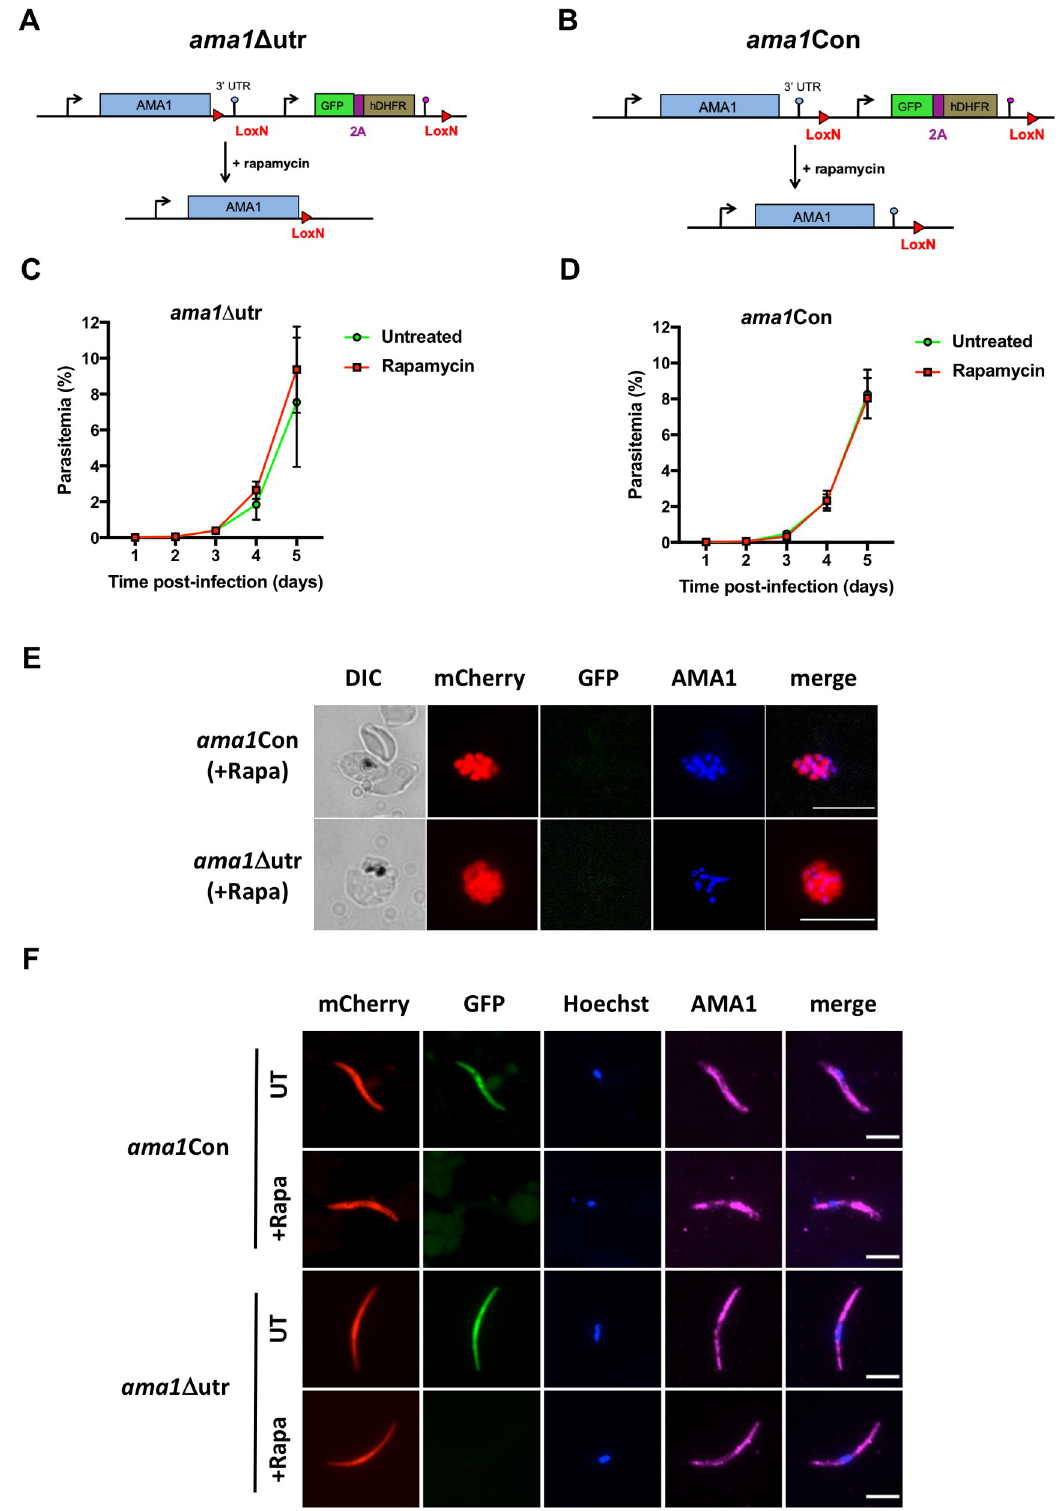
Fig 1. Deletion of the 3’ UTR of ama1 has no phenotypical impact in P . berghei . A-B. Strategy to generate ama1 Δ utr (A) and ama1 Con (B) parasites by modification of the wild type ama1 locus in PbDiCre parasites. C-D. Blood stage growth of untreated and rapamycin-treated ama1 Δ utr (C) or ama1 Con (D) parasites. Rapamycin was administered at day 2. The graphs represent